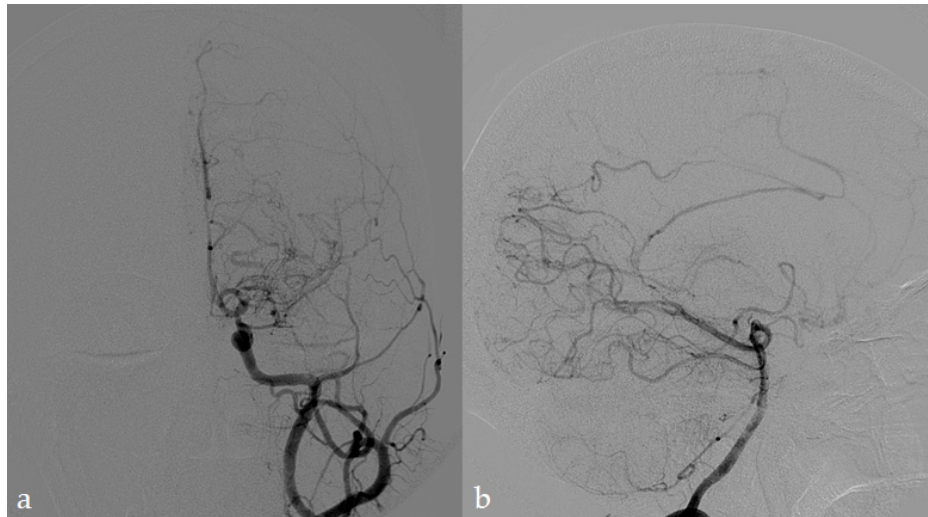
Figure 2. DSA in an MMA patient (same patient of Figure 1). The left ICA ( a ) depicts high-grade stenosis of terminal ICA and proximal M1 MCA segment with moyamoya collateralization pattern. Examining the left VA ( b ), cortical collaterals from PCA and ACA (callosal arcade) to superficial MCA territory are visible. (Imaging performed at the Neuroradiology Department, AUSL Reggio Emilia; pictures are reproduced with patient’s permission).